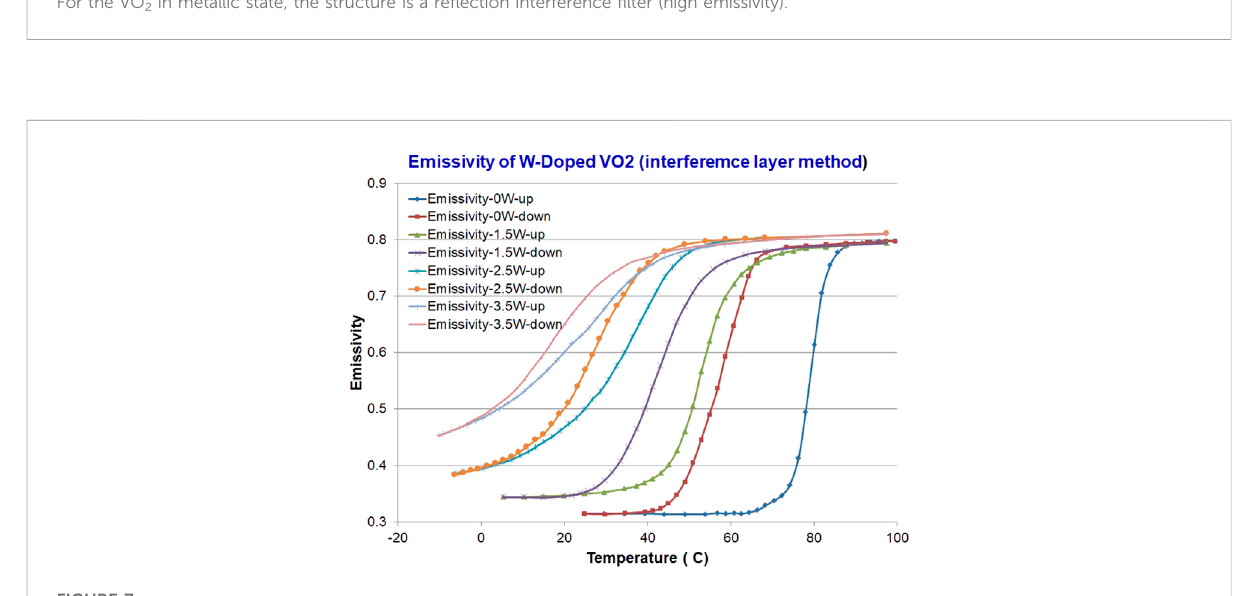
FIGURE 7 Evolution of the SRD Emissivity as a function of temperature for various %W doping (0% –